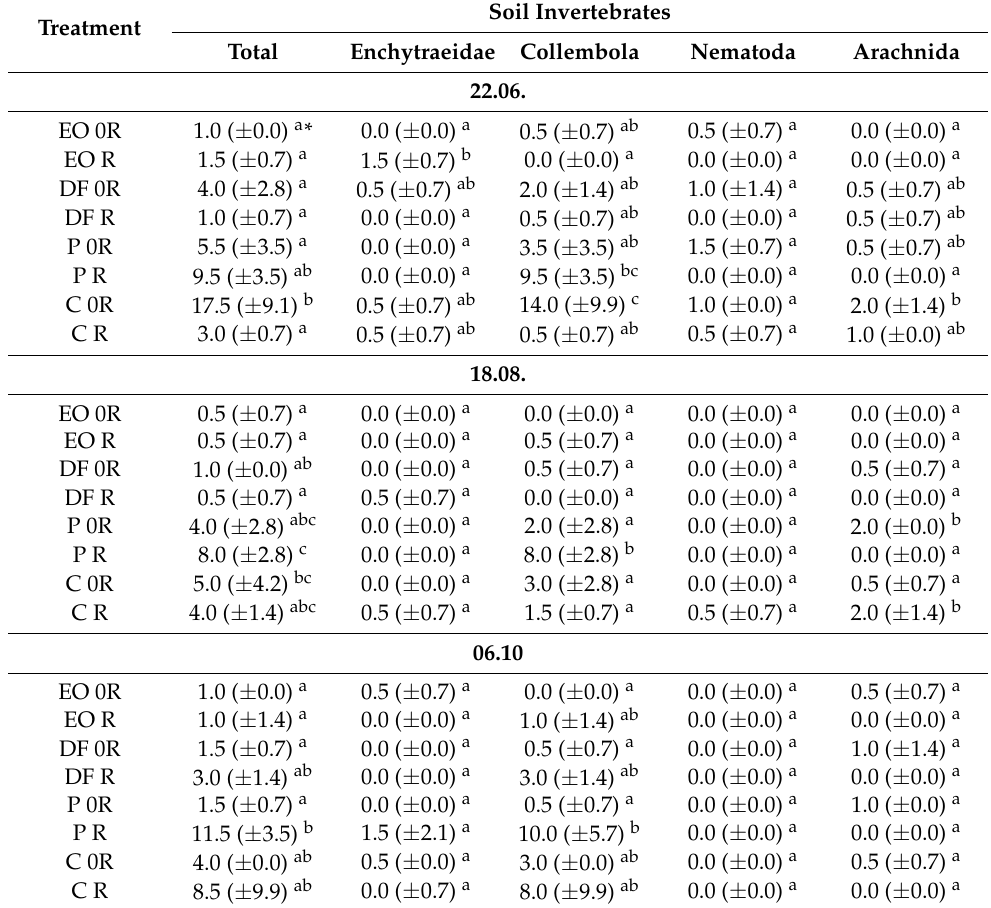
Table 3. The occurrence of soil invertebrates after five years from soil contamination and the use of ZB-01 (pcs. sample − 1 ).